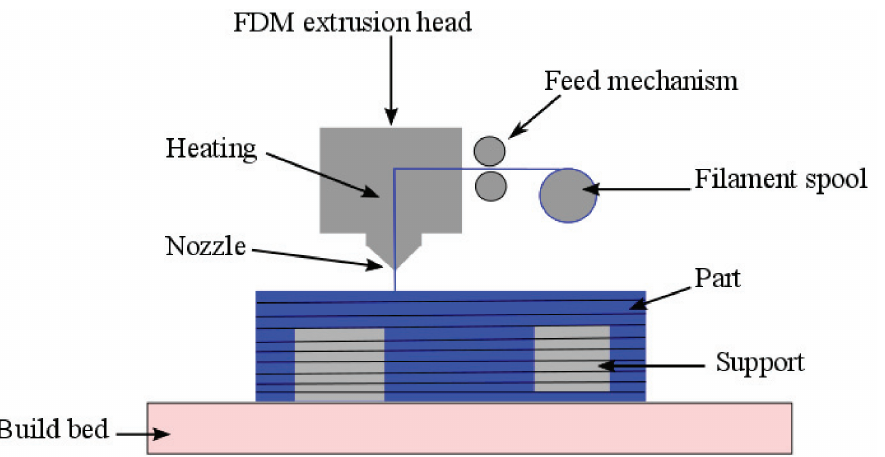
Figure 1. Schematic depiction of the fused filament fabrication process. The filament enters the extrusion head, which heats up the filament coming from the spool, after which the filament is extruded from the nozzle. The material is deposited onto the previously deposited layer to fabricate the desired object. Support material can also be extruded, which is removed afterward, to allow for a higher degree of complexity in the 3D-printed objects. Reproduced with permission [41], Copyright 2017,